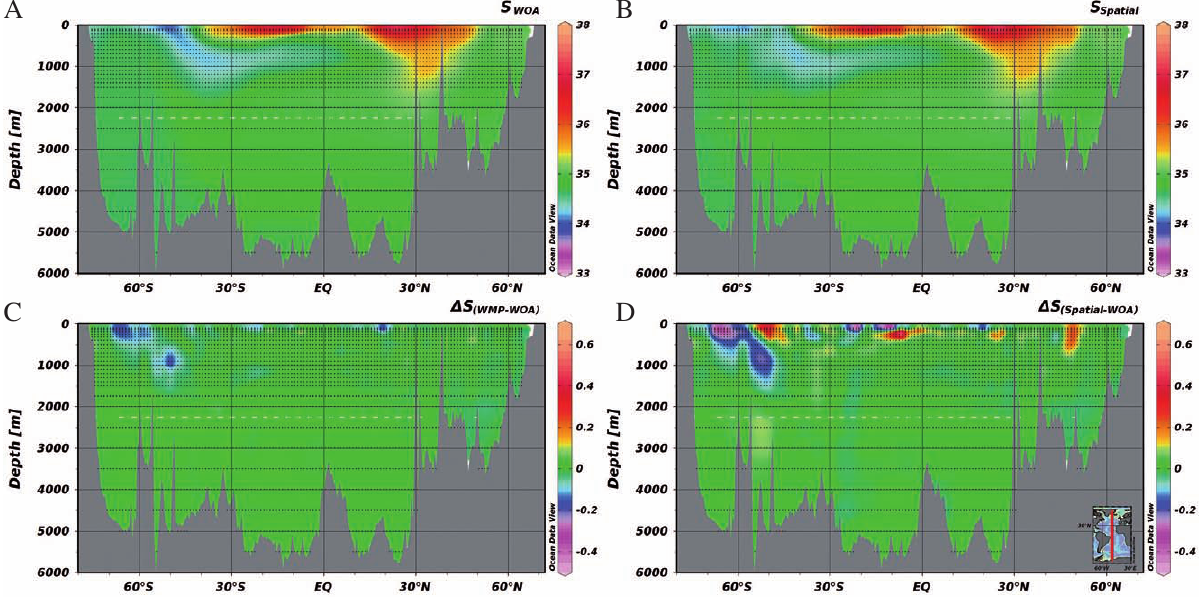
Fig . 3. – Salinity variability along 28ºW from the WOA05 dataset (A), spatially interpolated from CARINA data (B). Residuals of WMP interpolated (C) and spatially interpolated (D) salinity, both as interpolated minus